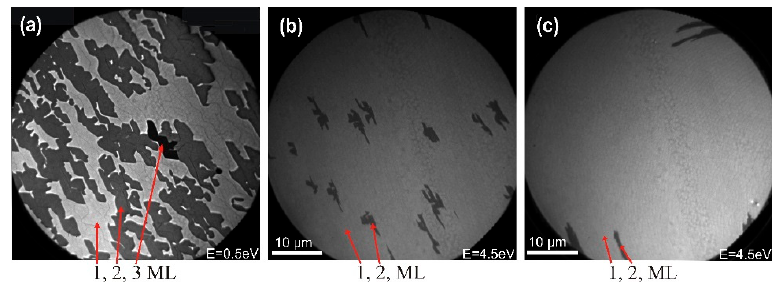
Figure 38. LEEM images of graphene on ( a ) 4H-SiC with 60% coverage by ML (bright area), darker areas represent bilayer while small black spot embodies three layers of graphene; ( b ) 6H-SiC with 92% of one ML coverage (bright area); ( c ) 3C-SiC with 98% one ML coverage (bright area). The black areas in ( b ) and ( c ) represent two ML graphene [22].